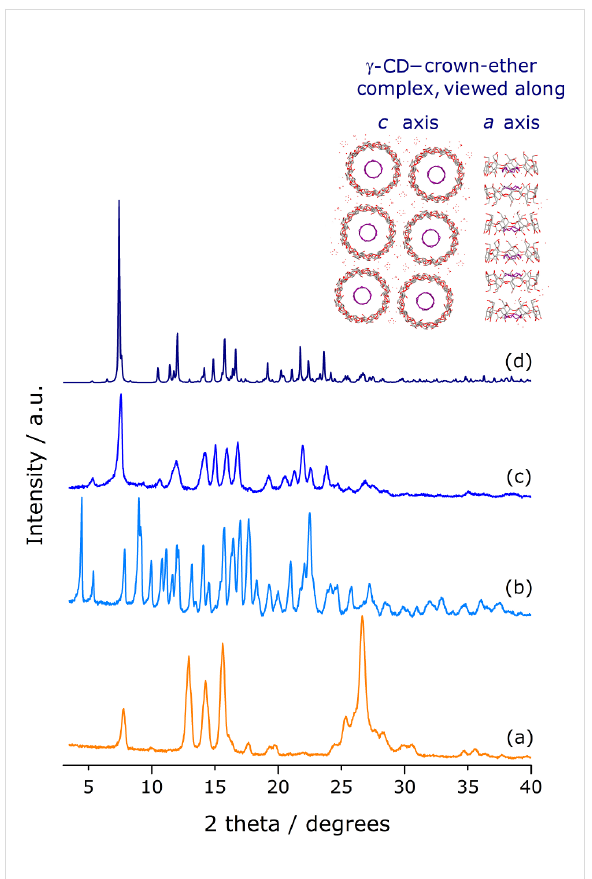
Figure 1: Powder X-ray diffraction patterns (PXRD) for (a) fisetin, (b) γ -CD heptahydrate and (c) the γ -CD·fisetin inclusion compound. Trace (d) was calculated from the atomic coordinates of the inclusion compound γ -CD–12-crown-4 ether [31] using the software Mercury 3.5.1 (copyright CCDC 2001–2014). The inset depicts the structure of γ -CD–12-crown-4 ether, as viewed from the top (crystallographic c- axis) and from the sides (crystallographic a-